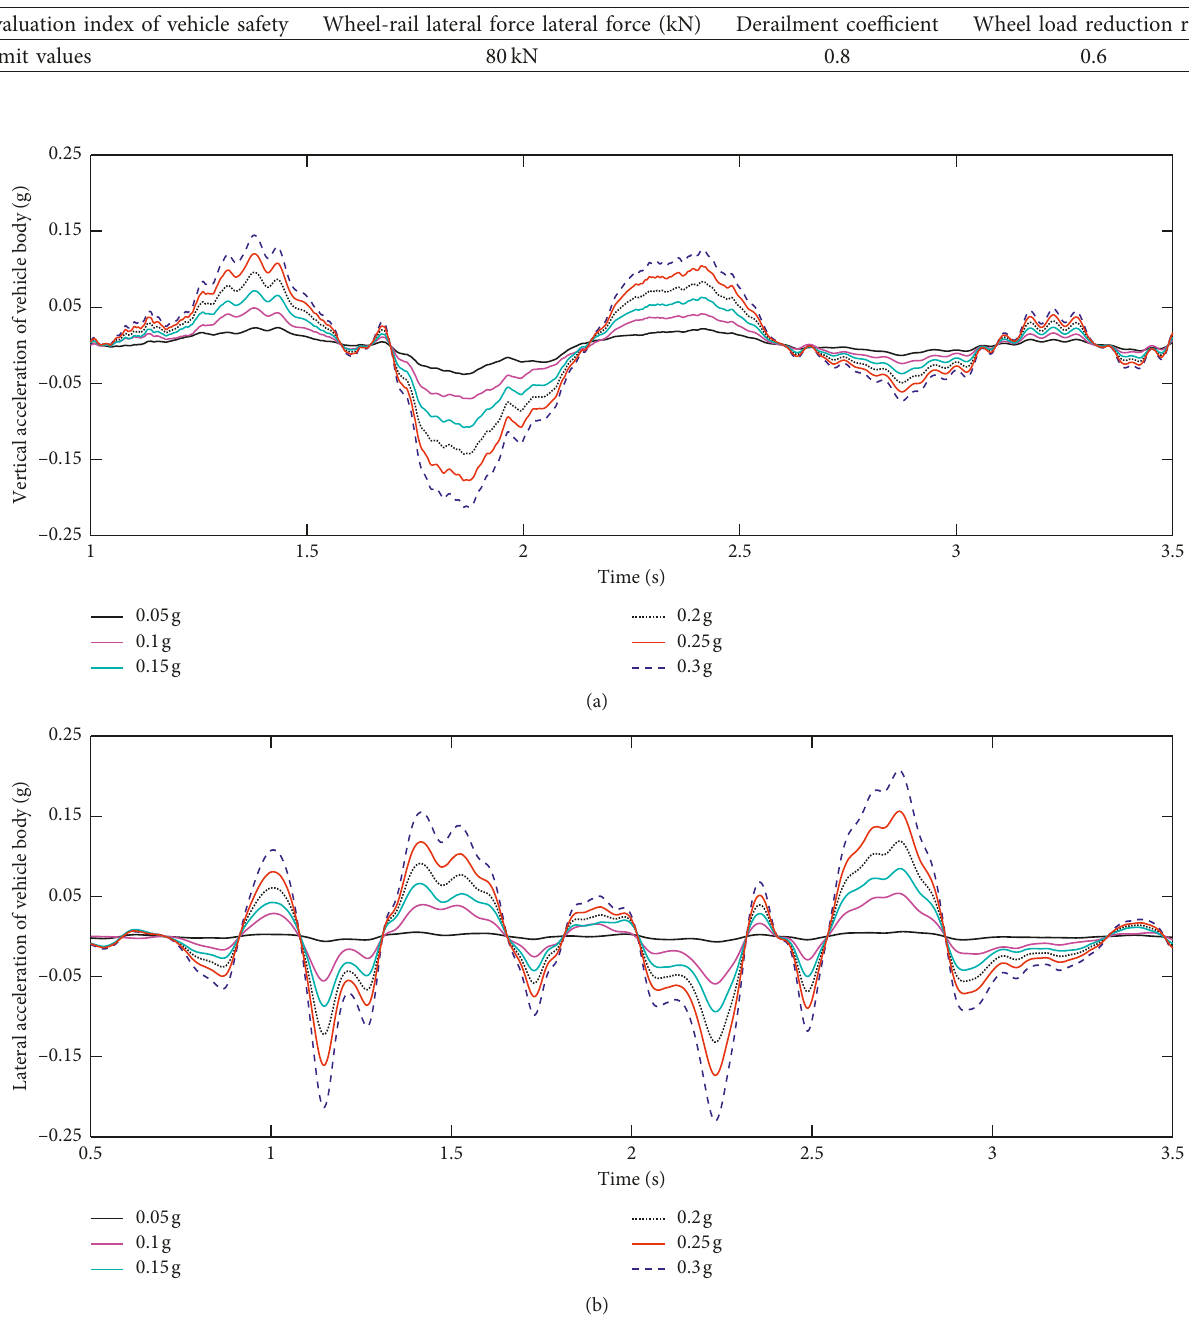
Table 3: Limit values of running safety